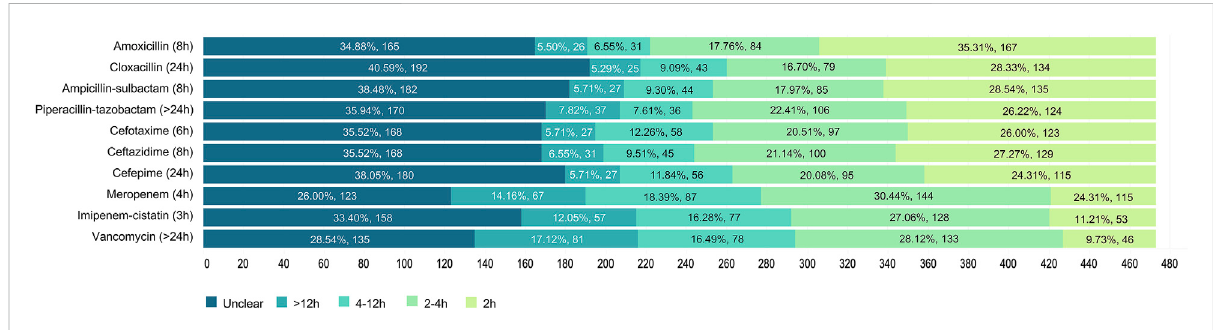
FIGURE 4 Participants ’ responses about the duration of stability of antibiotics